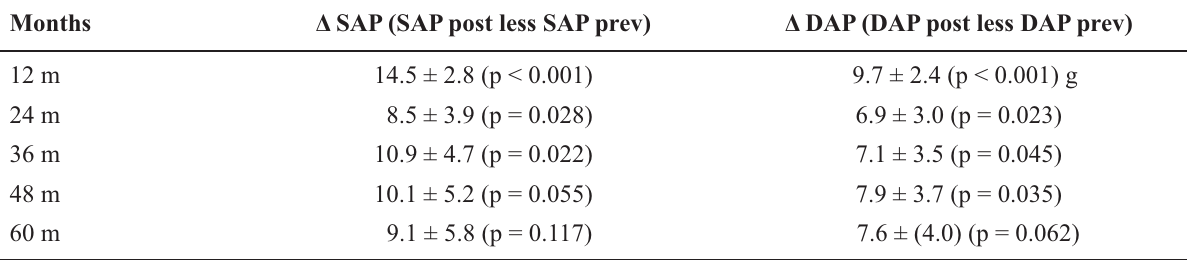
Table 4 – Differences in systolic and diastolic pressures as between the pre-operative period and each of the instants as- sessed in patients with RVH (in mm